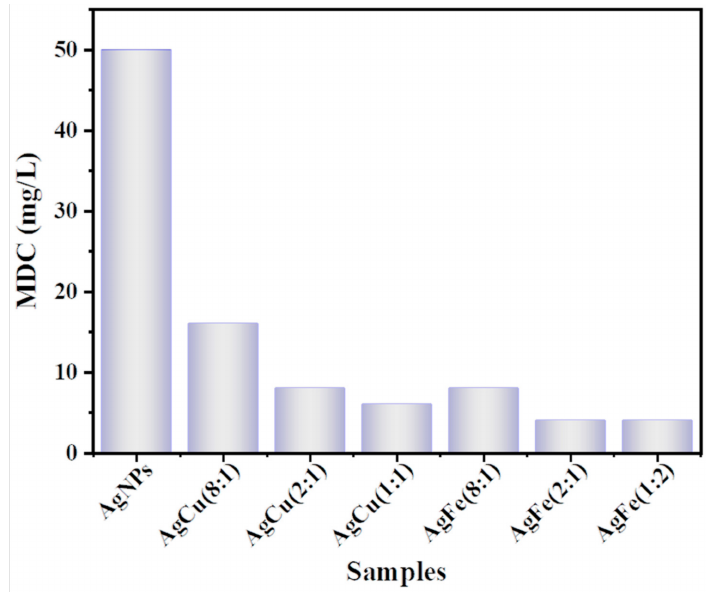
Figure 7. MDC values for various Ag/M ratios.